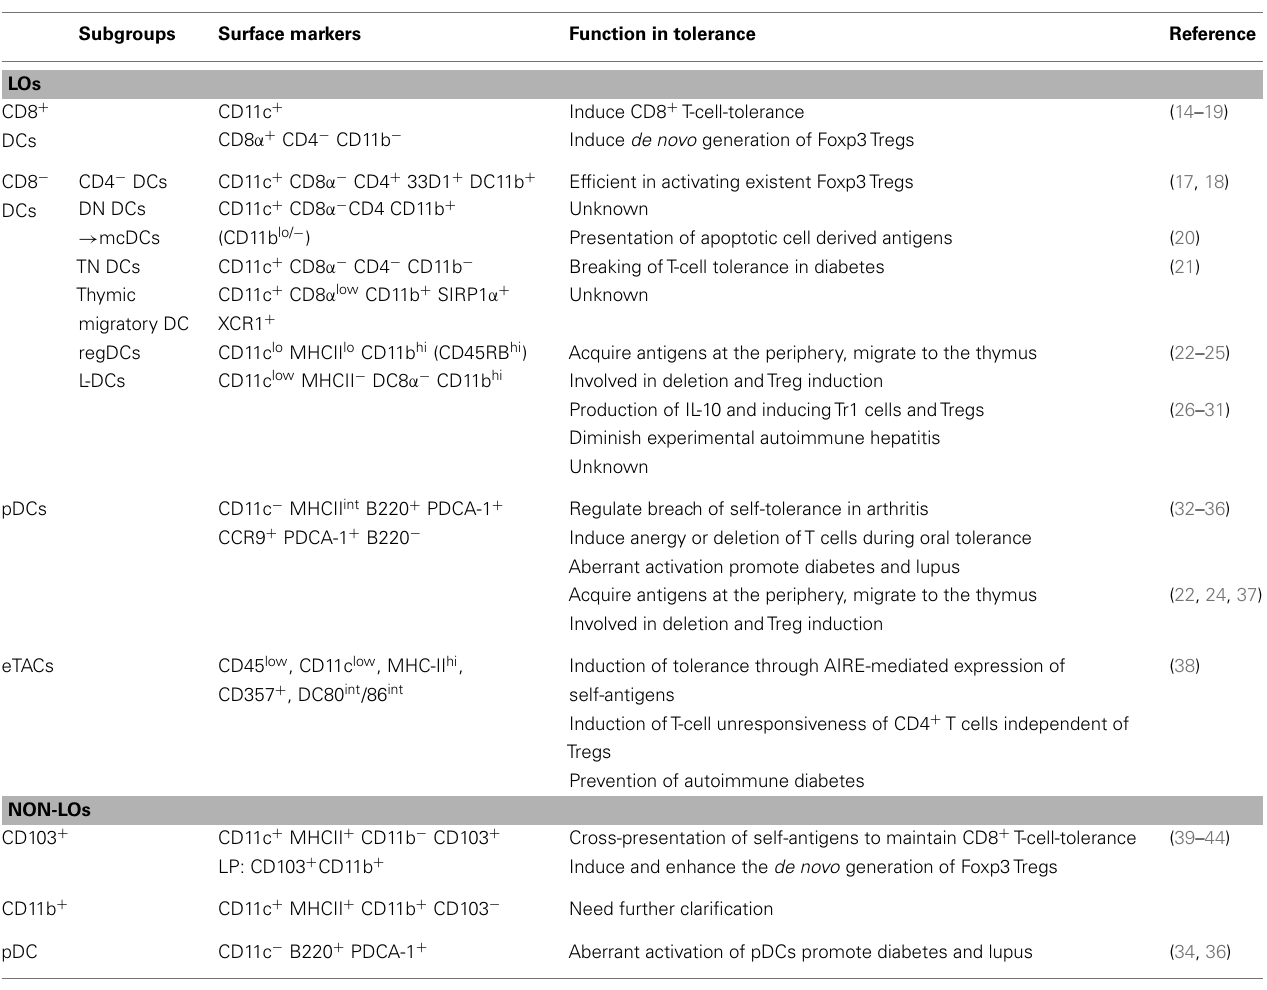
Table 1 | Murine DC subsets and their role in